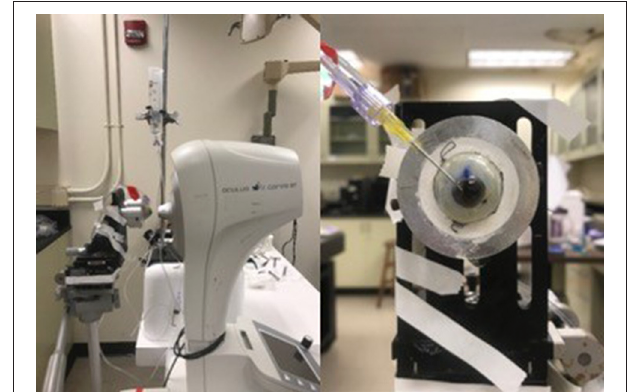
FIGURE 4 | (Left) Experimental setup for ex vivo studies on human donor eyes, showing a whole globe in the purpose-designed mount in front of the CorVis ST. (Right) A view of the human donor eye showing the 22-gauage needle inserted into the anterior chamber, used to set and maintain intraocular pressure.